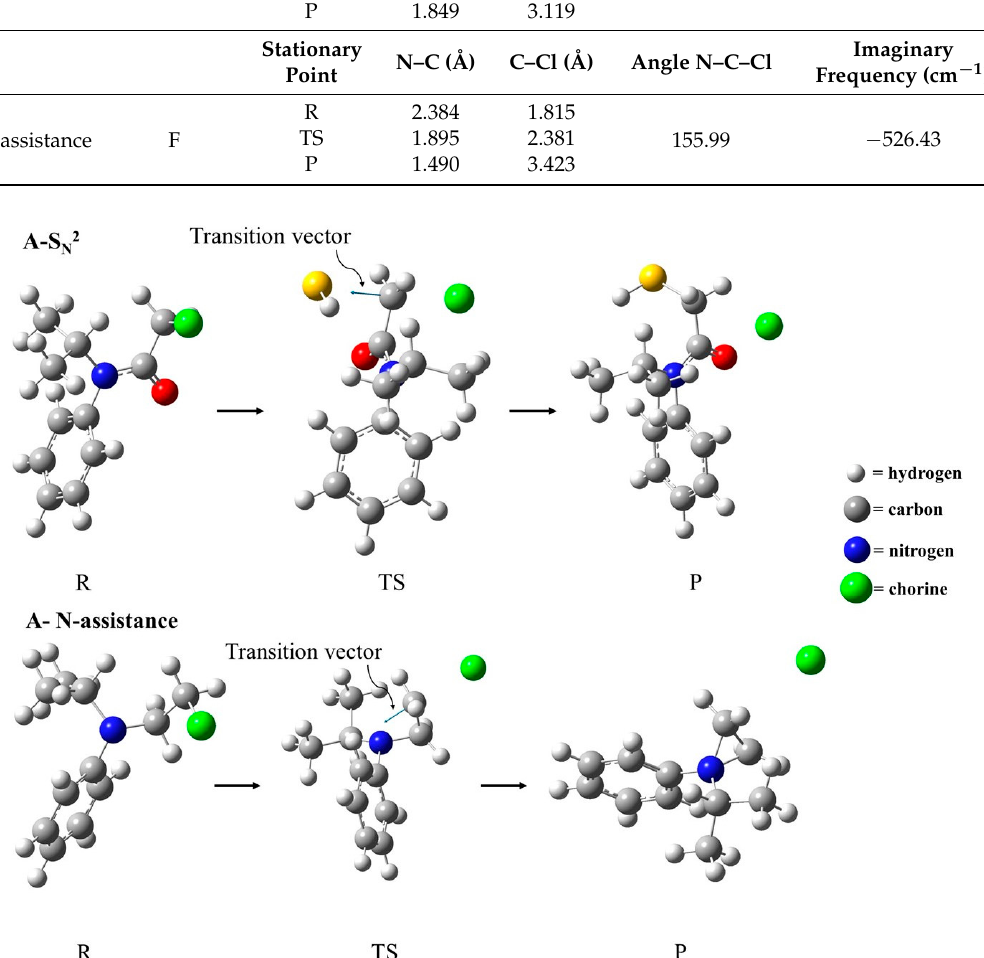
Figure 3. Optimized geometries of reactants (R), transition state (TS), and products (P) for the S N 2 reaction mechanism of compound A and the N-assistance mechanism of compound F.